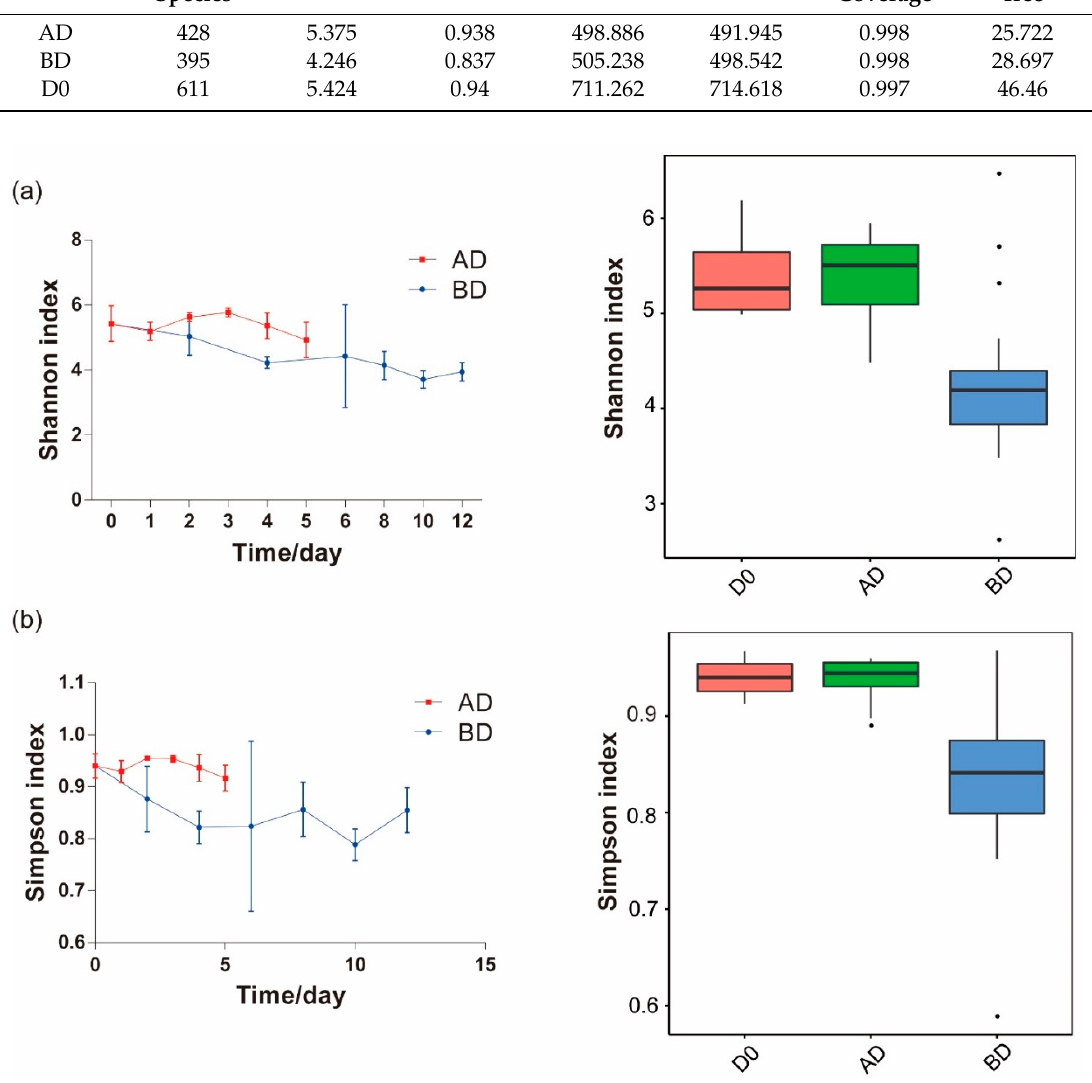
Figure 4. ( a ) The Shannon index and ( b ) Simpson index increase at high temperatures. D0 means 0-day, AD means 15 °C, and BD means 30